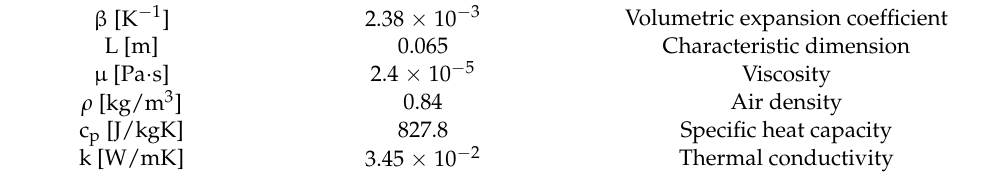
Table 7. Physical parameters for air at 420 K [92].